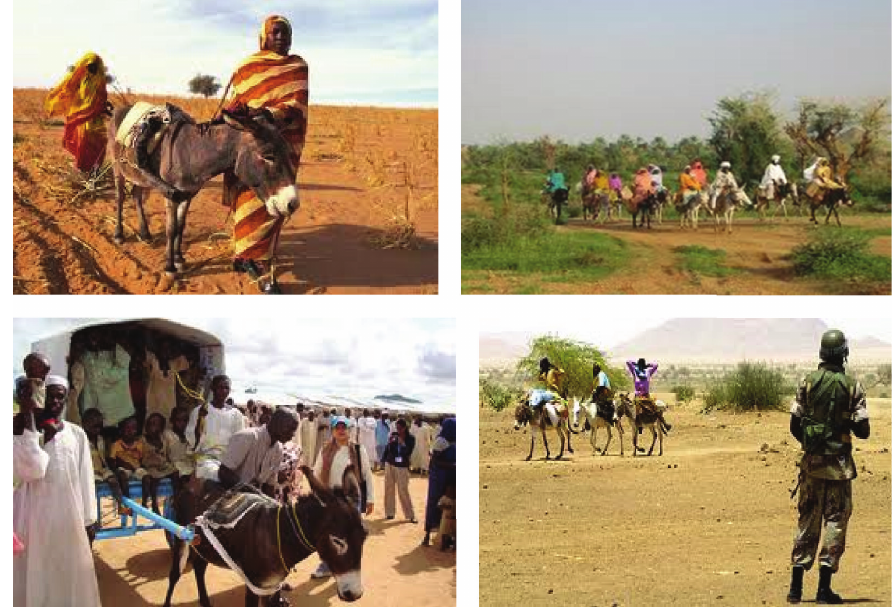
Figure 2: Climate and landscape of the study area. Pictures by the authors, 2011.